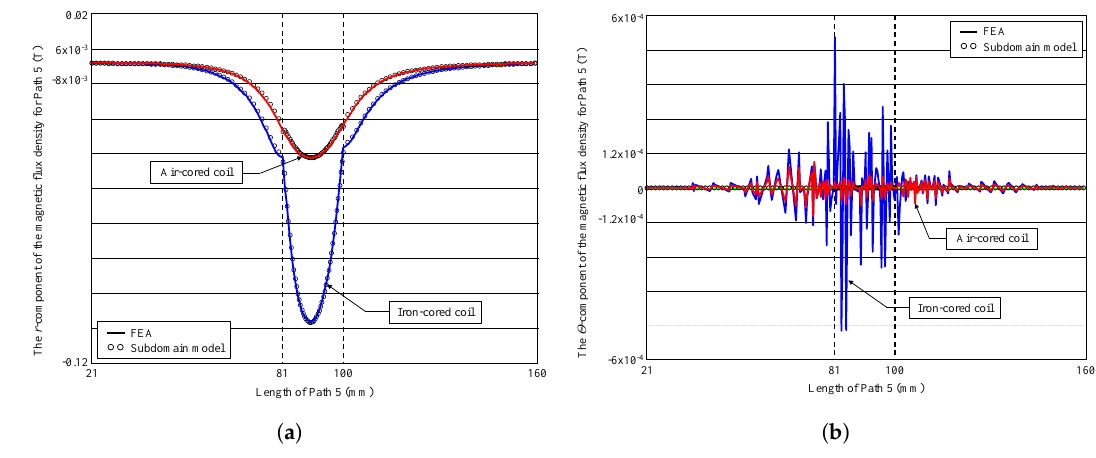
Figure 11. Waveforms of B for Path 5: ( a ) r - and ( b ) Θ